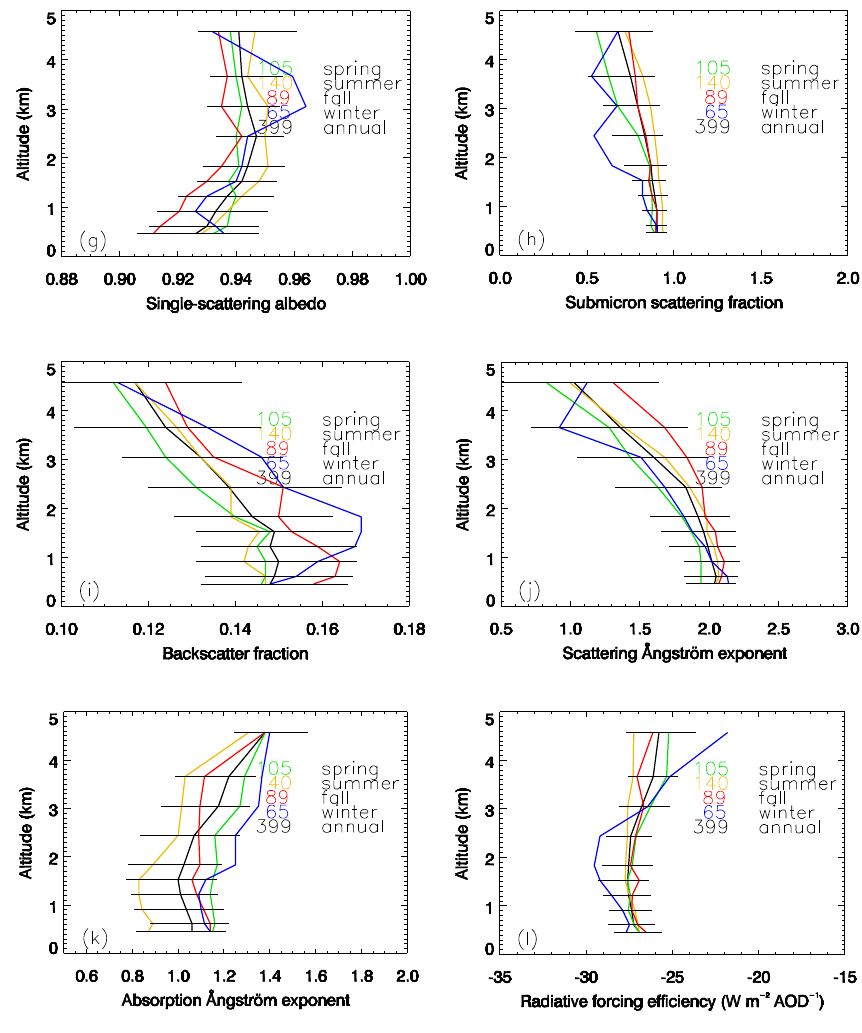
Fig. 10(g-l). Median seasonal profile plots of AAO measurements. Black profile in each plot represents all aircraft profiles. Horizontal bars show the extent of the 25th and 75th percentiles of the total